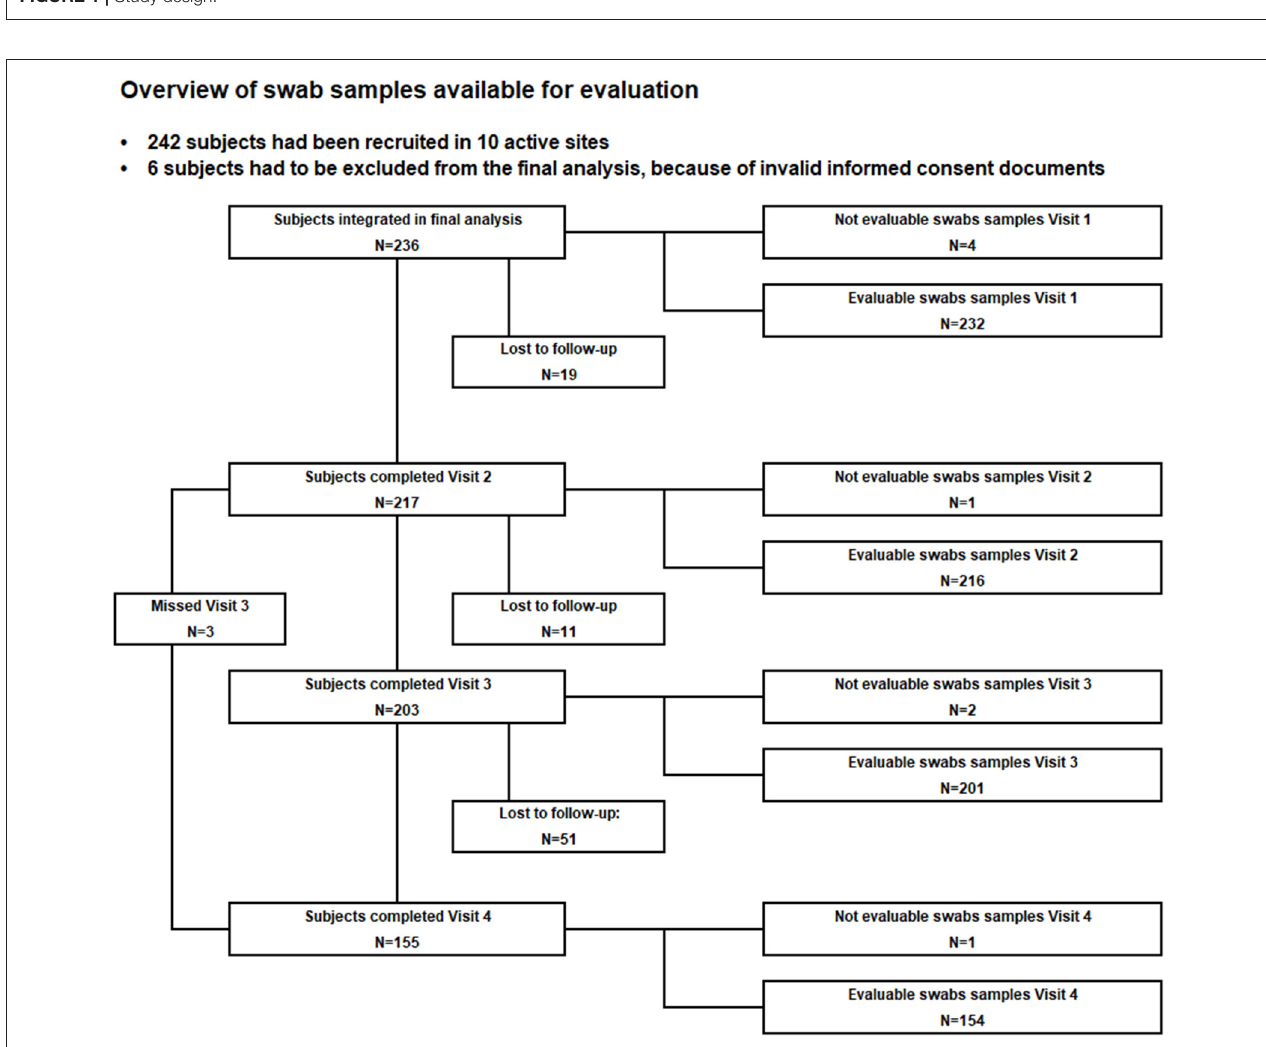
FIGURE 2 | Course of the study.